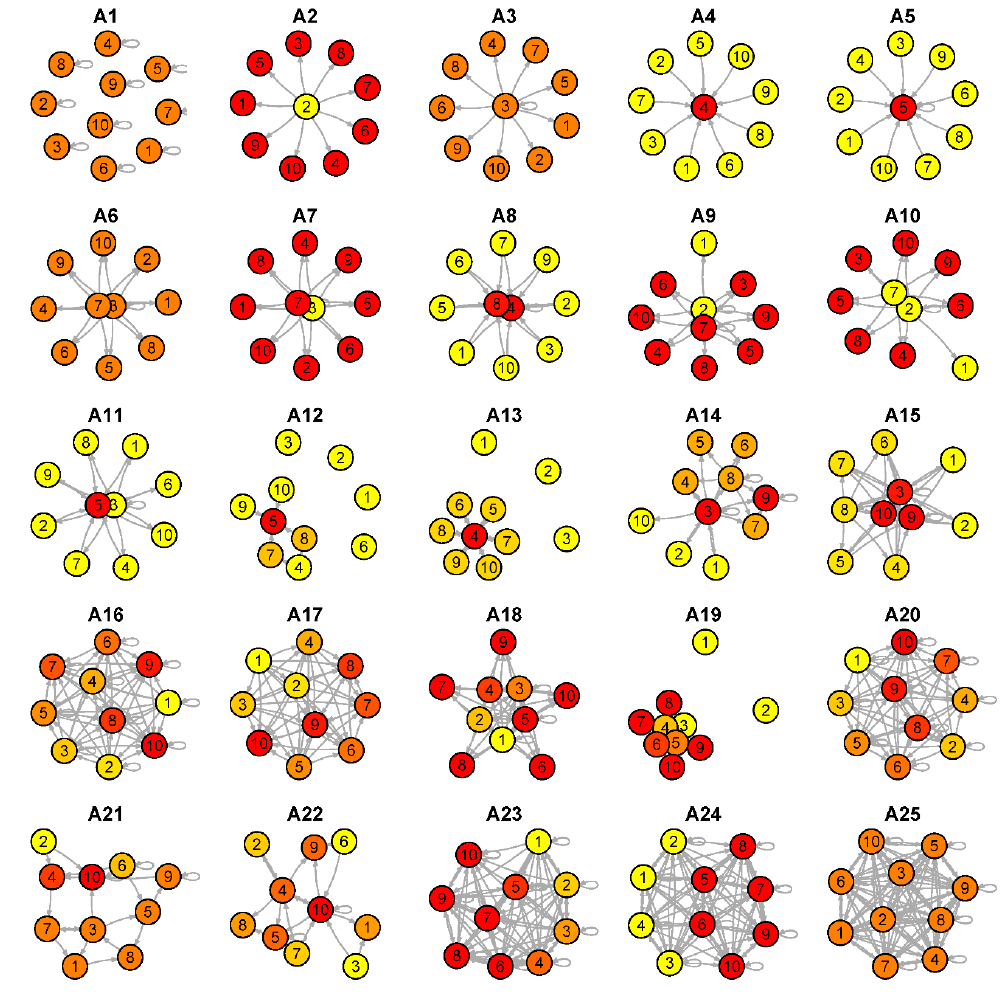
( i ) with in-degree centralities colored by the yellow-red gradient. Figure 1. Graphs G ((cid:3036)) with in-degree centralities colored by the yellow-red gradient. Figure A1. Graphs G